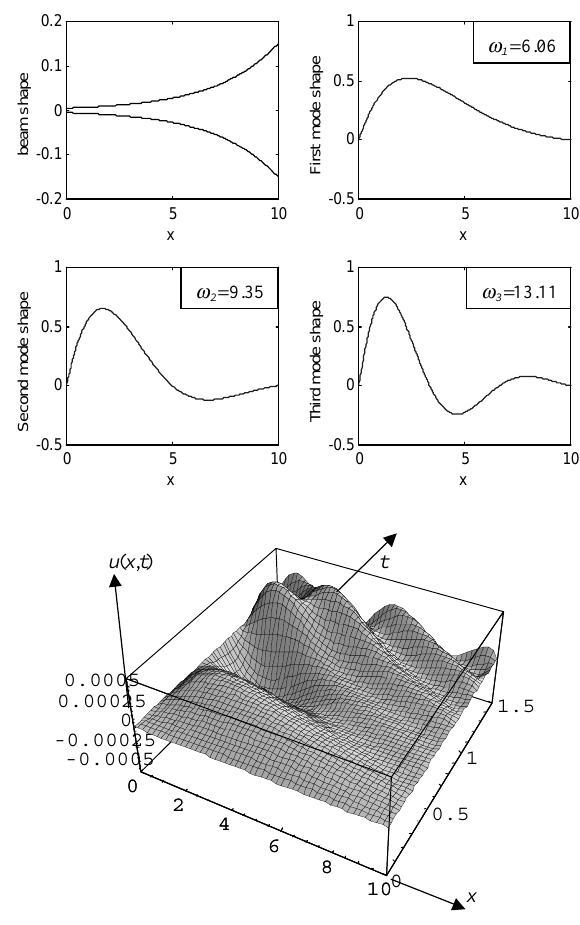
Fig. 3. Shape, first three eigenfunctions and time response of an aluminum fixed-fixed